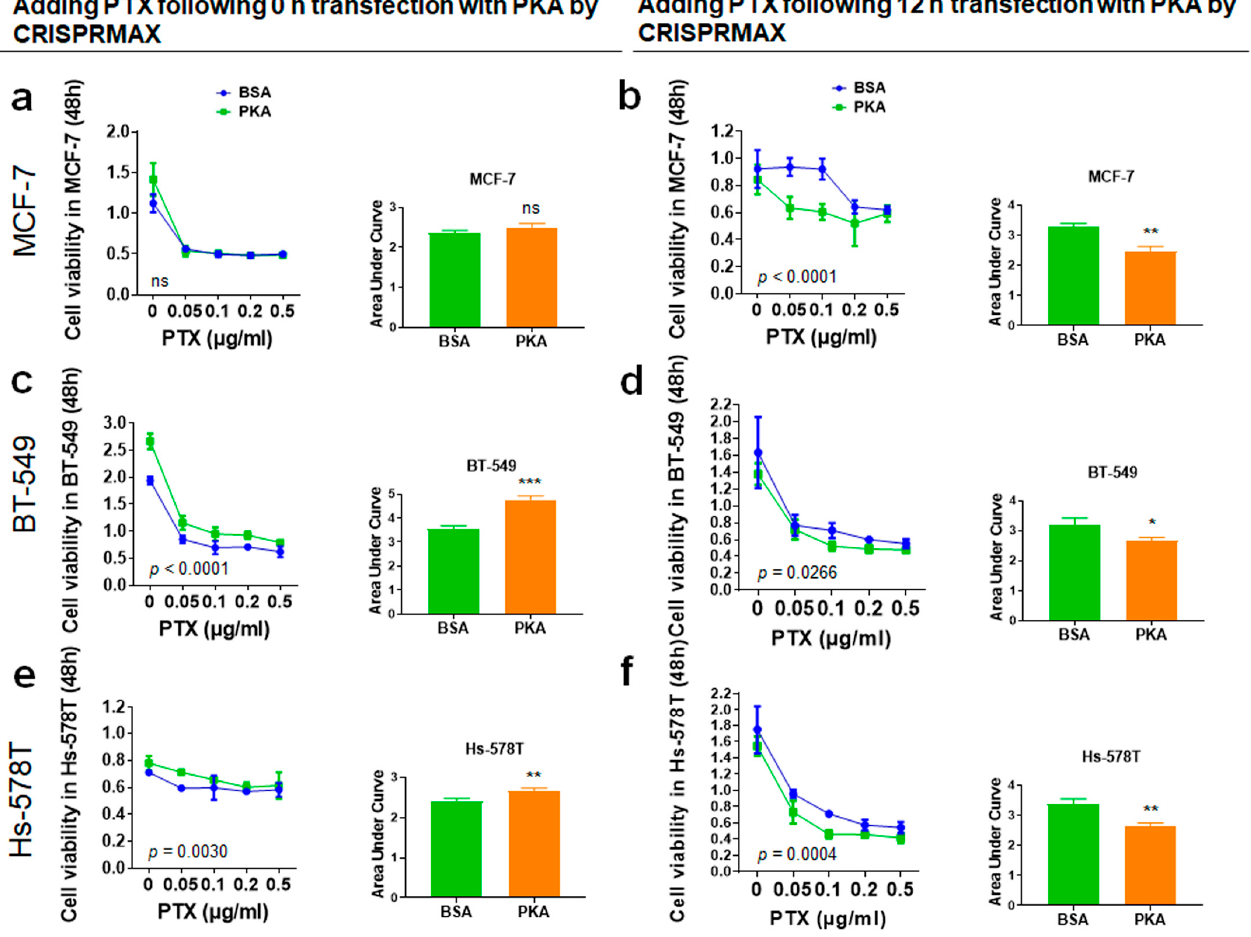
Figure 8. Chemoresistance assay of PTX in the cells following 0 or 12 h of transfection with CRISPRMAX-PKAs. ( a , c , e ) Adding PTX following 0 h of transfection with CRISPRMAX-PKAs: MCF-7, BT-549, and Hs-578T cells were transfected with PKA by CRISPRMAX and treated with PTX at 0, 0.05, 0.1, 0.2, and 0.5 µ g/mL simultaneously for 48 h; the results of AUC analyses in MCF-7, BT-549, and Hs-578T were compared with the BSA control group ( p = 0.1652, p = 0.0004, p = 0.0088, respectively). ( b , d , f ) Cells were treated with PTX for 48 h following 12 h of transfection with CRISPRMAX-PKAs; the results of AUC analyses in MCF-7, BT-549, and Hs-578T were compared with the BSA control group ( p = 0.0018, p = 0.0290, p = 0.0031, respectively). AUC analyses were used to compare the effectiveness of drug effect between the BSA and PKA groups. All treatments were performed with WST-1 cell viability assays and AUC analyses. Data were presented as Mean ± SD ( n = 3 replicates for transfection with the PKA and BSA group). In total, 500 ng of PKA and BSA (control) per setup were used, and the PKA group was compared with the BSA control in each setup. Statistical significances were evaluated using unpaired two-tailed t test; * p < 0.05, ** p < 0.01, *** p < 0.001, and ns, not significant. PTX, paclitaxel.